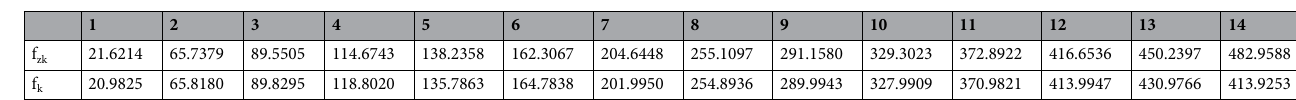
Table 2. The center frequency and the mean values of instantaneous frequency of every